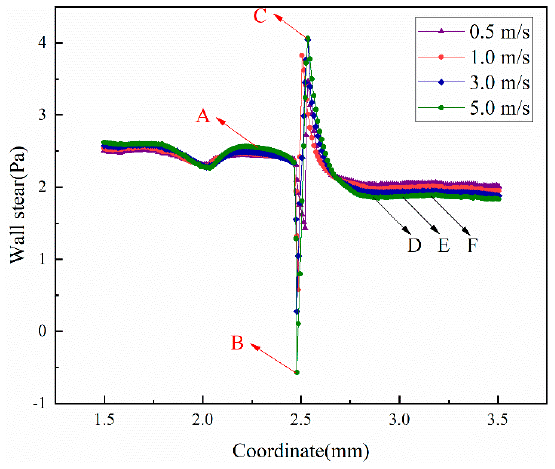
Figure 13. Wall shear stress along the flow direction.